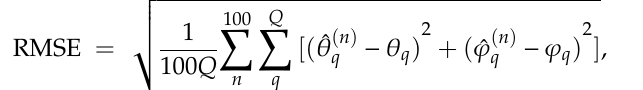
( b ) The normalized spectral function derived from the STC-MUSIC algorithm ( 4 M , 4 L , 8 K ).